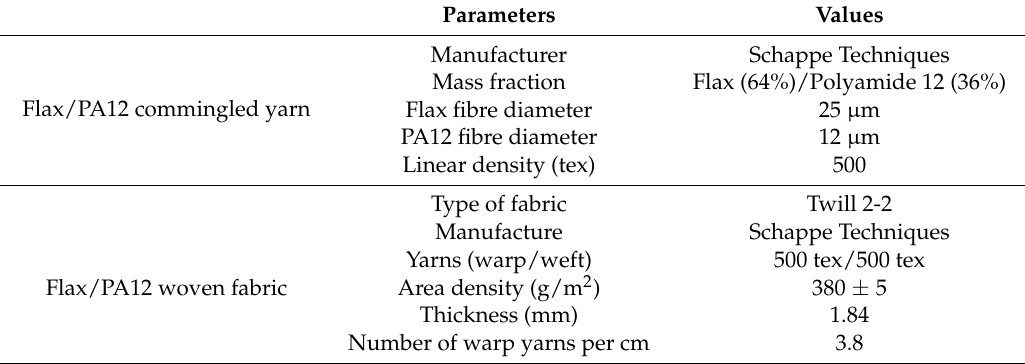
Table 1. The main properties of the Flax/PA12 commingled yarn and woven fabric.